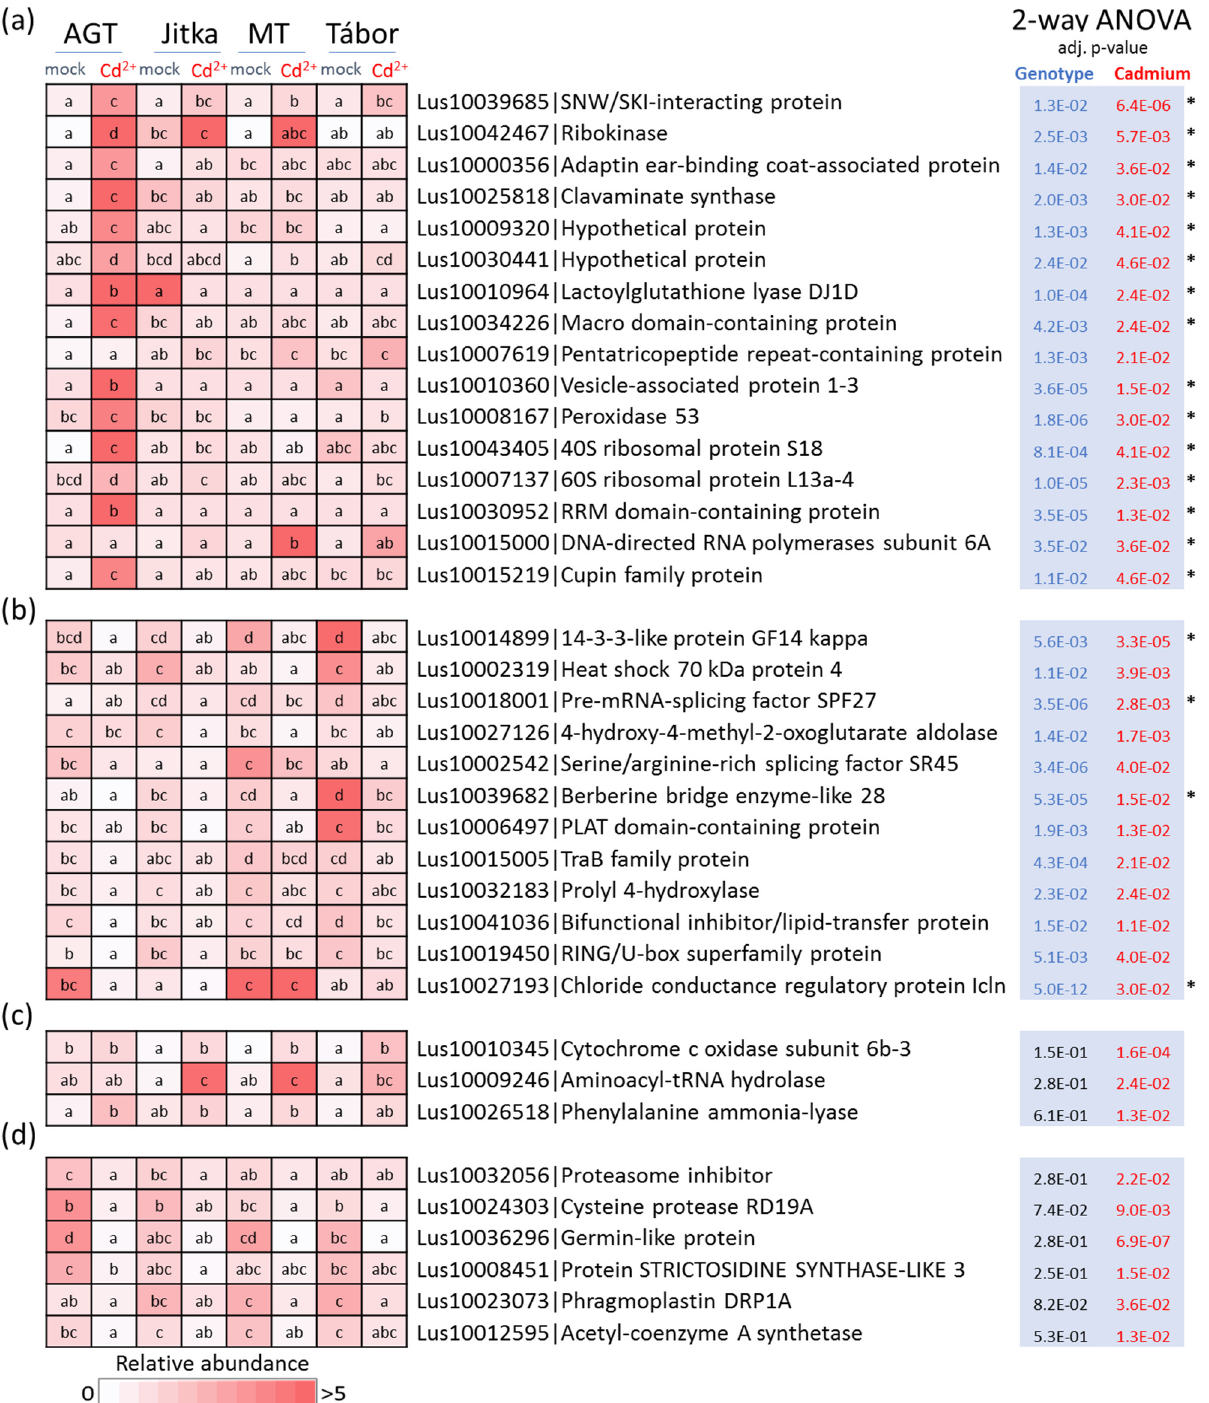
Figure 3. Cadmium-responsive proteins identified in flax suspension cultures. ( a , b ) Genotype-specific effect on protein abundance combined with ( a ) the cadmium-induced accumulation and ( b ) a decrease in abundance. ( c , d ) Genotype-independent effects of cadmium on protein accumulation ( c ) and decrease in abundance ( d ). Heat maps represent the mean relative abundances of five biological replicates; letters represent the results of Kruskal-Wallis and Dunn’s test ( p < 0.05); blue, significant effects of genotype; red, significant effects of cadmium; asterisks represent significant interaction between genotype and cadmium concentration.